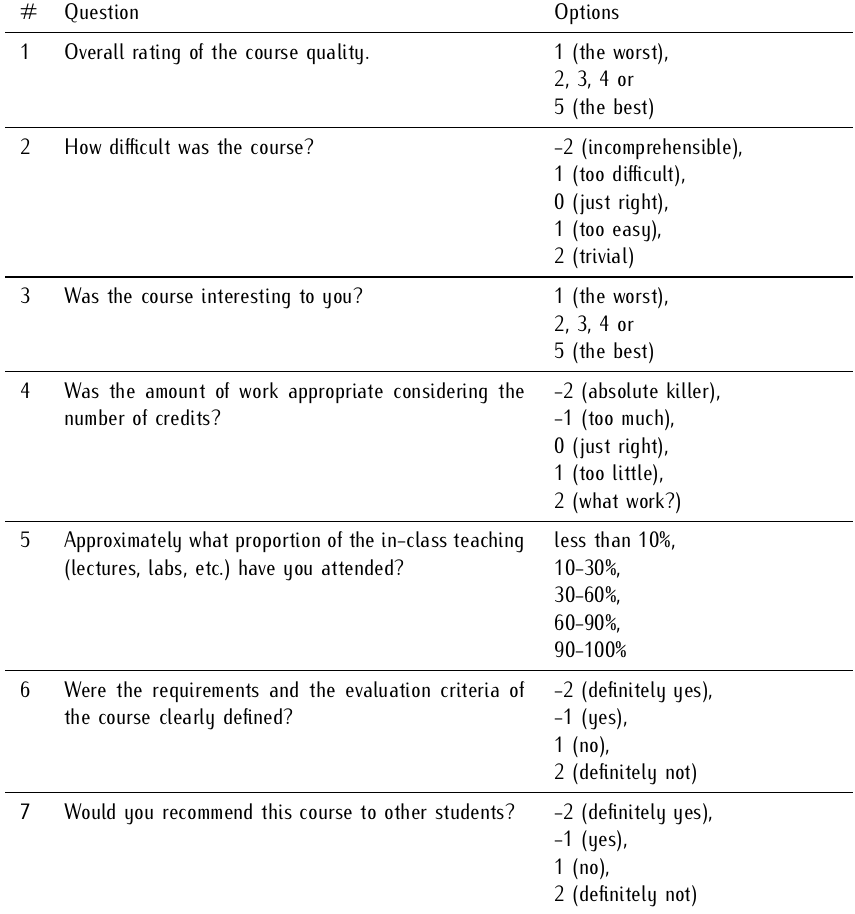
Table 1. Questions from official student feedback form.